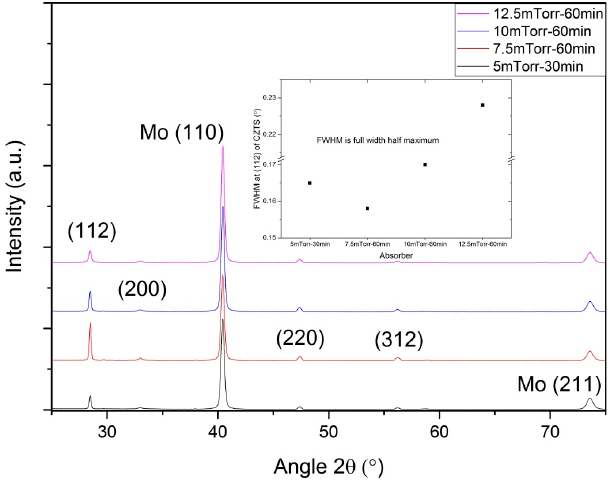
Figure 3. XRD patterns of CZTS absorbers fabricated from various precursors: 5 mTorr ‐ 30 min, 7.5 mTorr ‐ 60 min, 10 mTorr ‐ 60 min, and 12.5 mTorr ‐ 60 min.